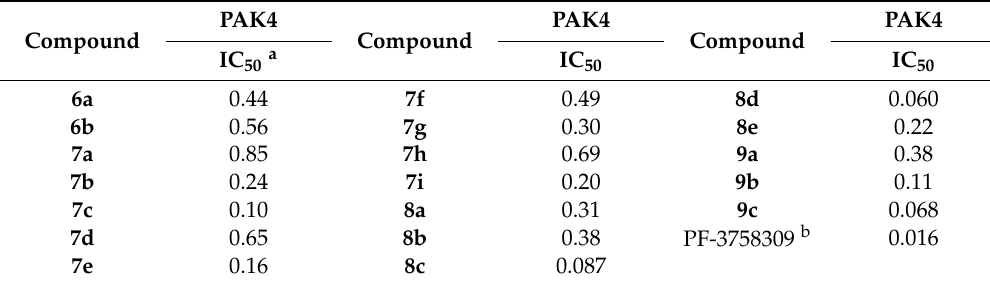
Table 1. IC 50 values ( µ M) of the synthesized compounds against PAK4.